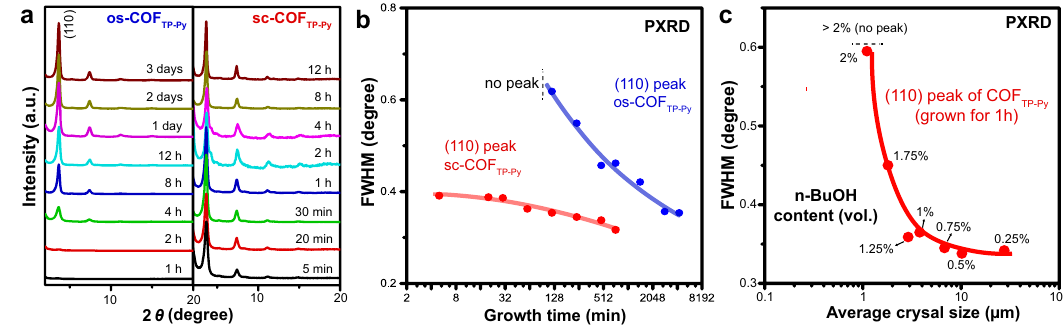
Fig. 3 Ultra-fast crystal growth of sc-COFs. a PXRD of the samples of os-COF TP-Py and sc-COF TP-Py grown for different times. b FWHM of sc-COF TP-Py (110) and os-COF TP-Py (110) peaks as a function of growth time. c FWHM of the COF TP-Py (110) peak and average crystal sizes of the products grown for 1 h in a mixture solvent of n-BuOH and sc-CO 2